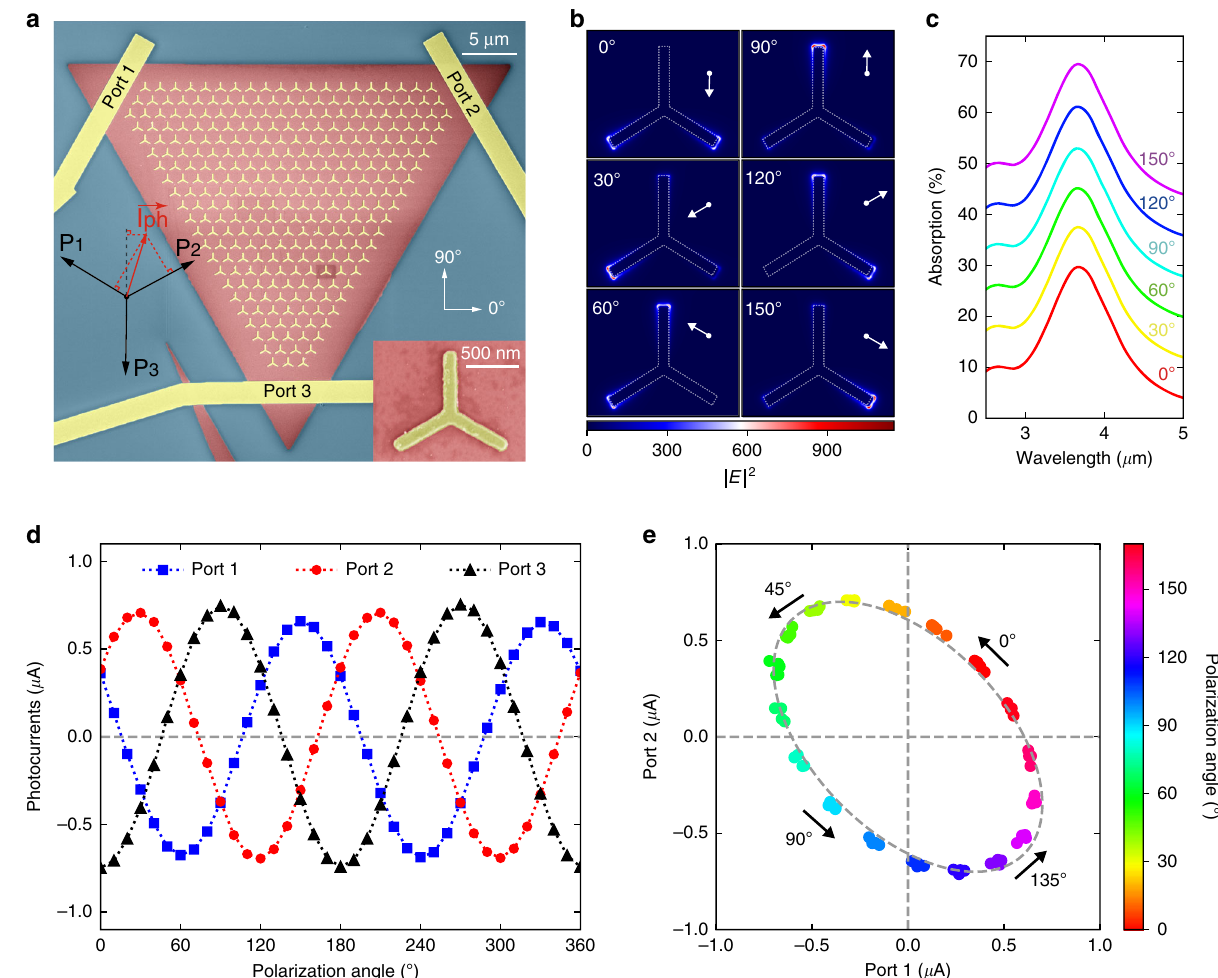
Fig. 4 Calibration-free polarization detection. a SEM images of a three-port device for calibration-free polarization detection. The bottom left inset shows how the I ph is decomposed into the currents measured at the three ports. The scalar projection is valid in our case because of the three-fold rotation symmetry. Bottom right inset shows the zoom-in graph of a single triangle nanoantenna. b Simulated near- fi eld distribution of the half unit cell and predicted direction of photocurrent at different polarization angles ( θ ). c Far- fi eld absorption spectra of metasurface, which show no dependence on the polarization angle due to the three-fold rotation symmetry. The spectra have been shifted vertically for better clarity. d Measured photocurrent at the three ports as a function of polarization angles. No external bias is applied. The results can be well fi tted with P 1 ~cos(2 θ + π / 3), P 2 ~cos(2 θ − π / 3), P 3 ~cos(2 θ − π ). e Two-dimensional plot of P 1 and P 2 . By sweeping the polarization angle, ( P 1 , P 2 ) pairs form a closed curve that ful fi lls the equation of an ellipse. The light intensity and polarization can then be decoupled, enabling an unambiguous detection of the polarization state using a